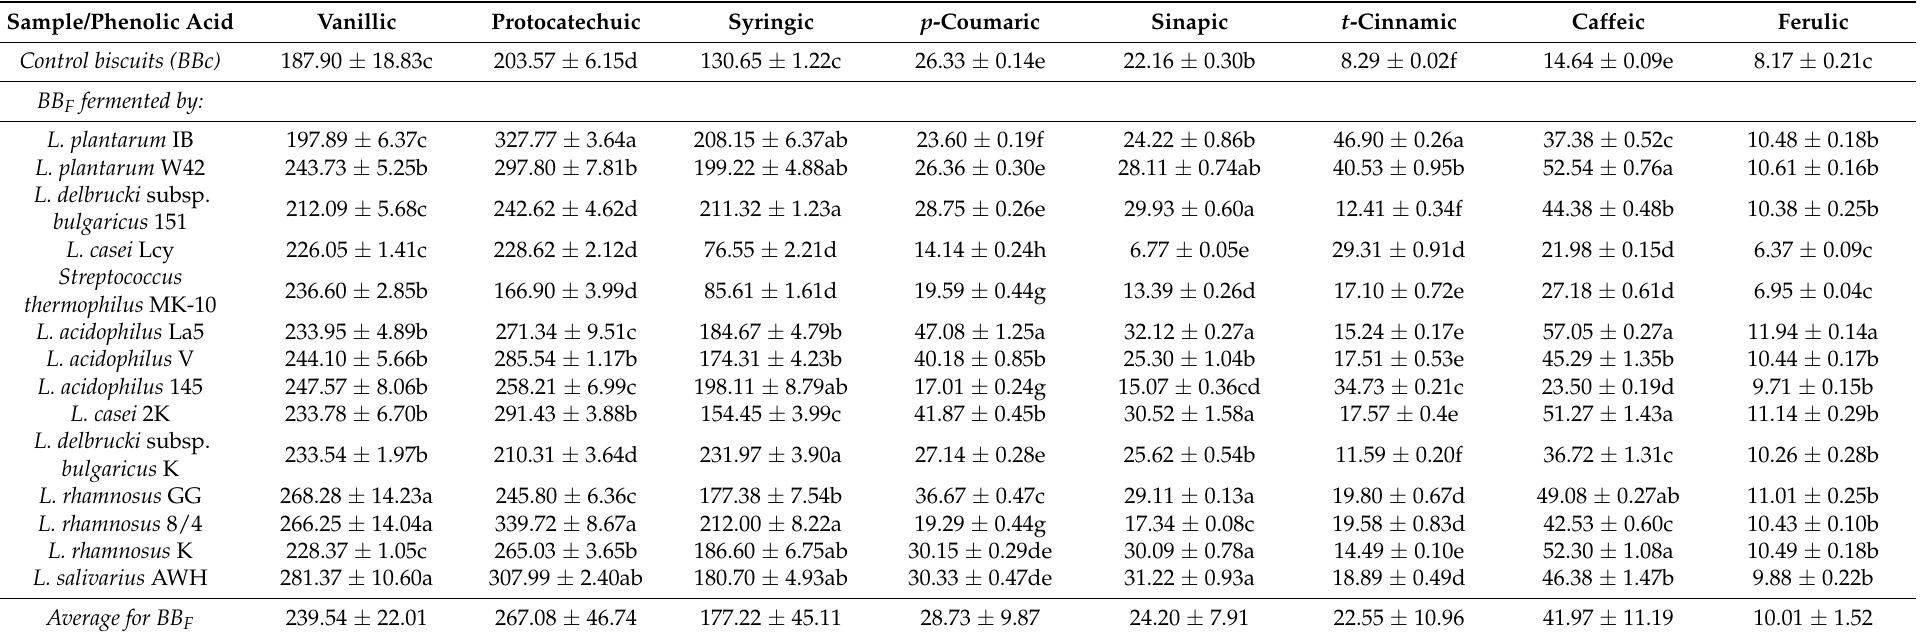
Table 2. The content of phenolic acids ( µ g/g DM) in buckwheat biscuits prepared from not fermented (BB C ) and fermented flours (BB F ) by selected lactic acid bacteria after in vitro digestion. Data are expressed as mean ± standard deviation ( n = 3). Means in each column followed by different letters are significantly different ( p < 0.05) based on the one-way analysis of variance